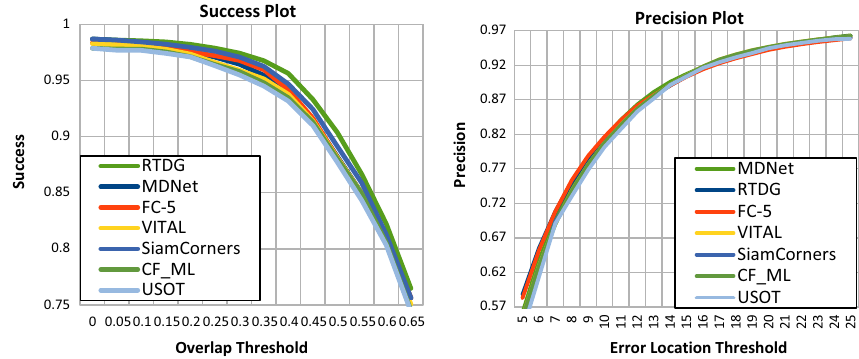
Fig. 6 Precision and success plots on the OTB‑2015 dataset using OPE evaluation